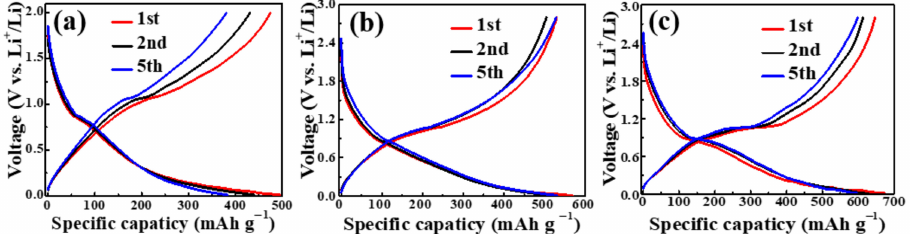
Figure 4. Galvanostatic discharge/charge curves of the 1st, 2nd, 5th cycles for ( a ) Sb 1 , ( b ) Sb 2 and ( c ) Sb 3 at a current density of 100 mA g − 1